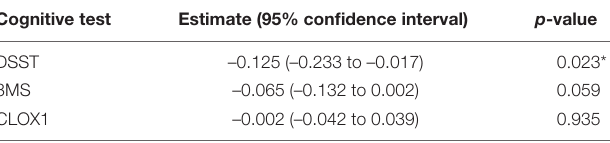
TABLE 4 | Univariable (unadjusted) linear mixed models. Cognitive test